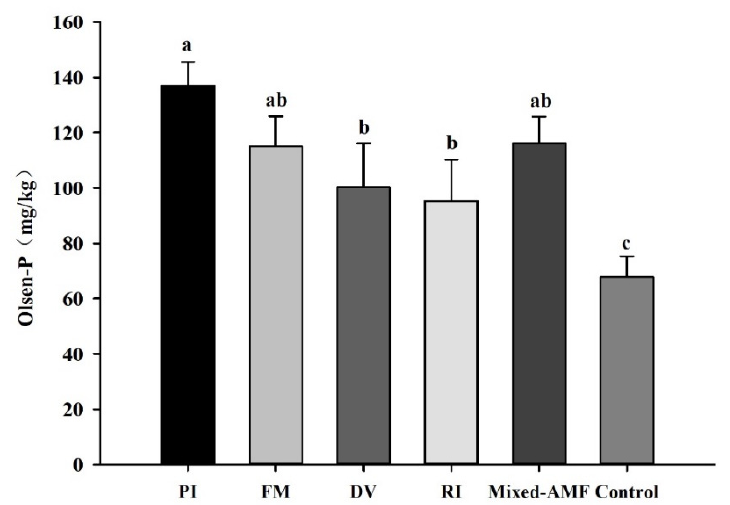
Figure 3. Effects of symbiotic fungi on soil Olsen-P concentrations of Camellia oleifera plants. Data (means ± SD, n = 6) followed by different letters above the bars indicate significant ( p < 0.05) differences. The abbreviation is the same as Table 2.